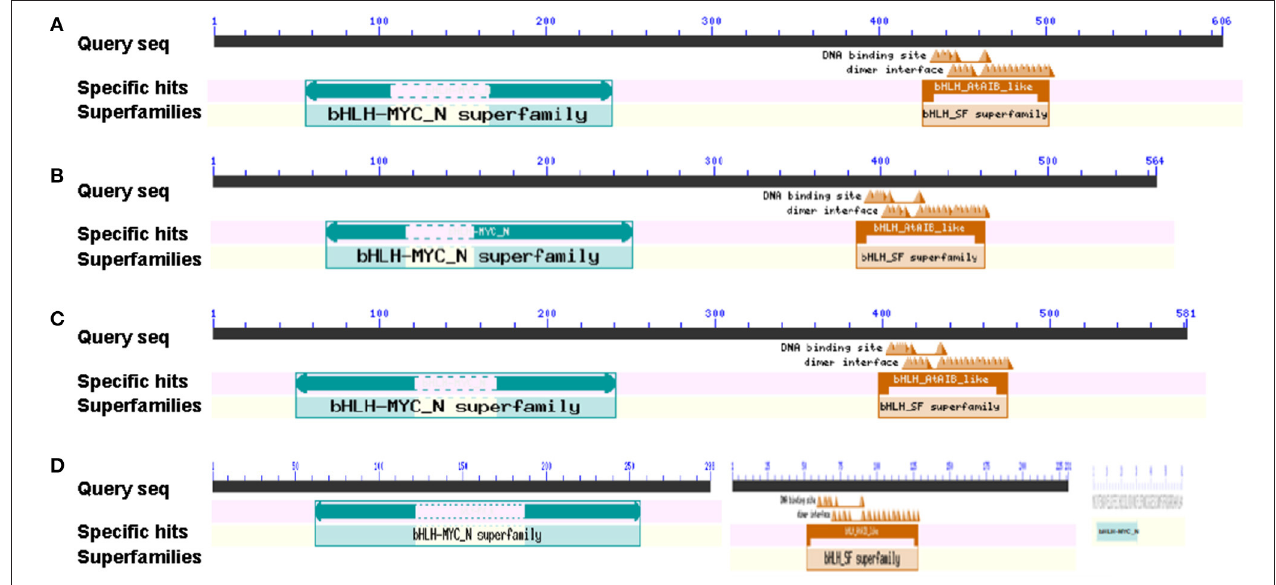
FIGURE 1 | Putative BrMYC2/3/4 DNA-binding domains in Chinese cabbage. (A) BrMYC2 DNA-binding domains. (B) BrMYC3-1 DNA-binding domains. (C) BrMYC3-2 DNA-binding domains. (D) The DNA-binding domains illustrated; from left to right are BrMYC4-2 , BrMYC4-1 , and BrMYC4-3 .